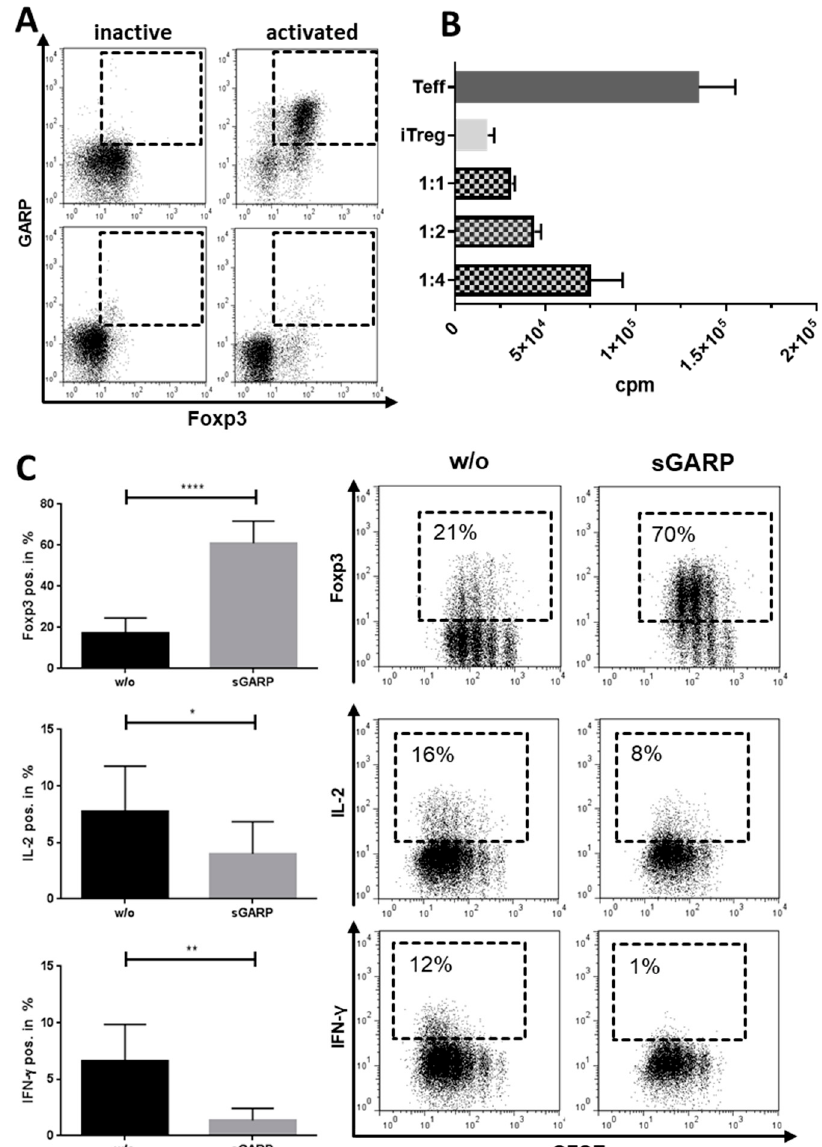
Figure A1. sGARP induced Treg. ( A ) GARP expression on Treg vs. Teff: GARP is an activation marker on Treg. 16h after stimulation, CD4 + CD25 + Treg showed a strong GARP expression compared to CD4 + CD25 − Teff. One representative dot plot of four different experiments is shown. ( B ) Suppressive capacity of sGARP-conditioned T cells. CD4 + CD25 − T cells were stimulated with 0.5 µg/mL anti-CD3 mAb and 1.0 µg/mL anti-CD28 mAb for 6 days in the presence of 10 µg/mL sGARP, resulting in Treg. Simultaneously, allogenic Teff were generated without the use of sGARP. After 6 days of stimulation, Teff and titrated Treg were cocultured and re-stimulated with anti-CD3 mAb and irradiated PBMC. After 4 days, proliferation was determined by tritiated thymidine ( 3 H TdR) pulse. Results show the pooled data of three independent experiments. ( C ) sGARP induction of FoxP3, inhibition of proliferation, and inhibition of effector cytokine production in CD4 + T cells ( n = 3, means ± SD, * p < 0.05, ** p ≤ 0.01, *** p ≤ 0.001, and n.s. determined by one-way ANOVA).